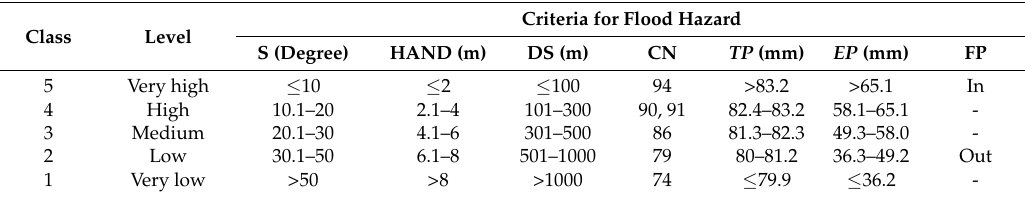
Table 2. Classes of criteria that contribute to flood hazard. S: slope, HAND: height above